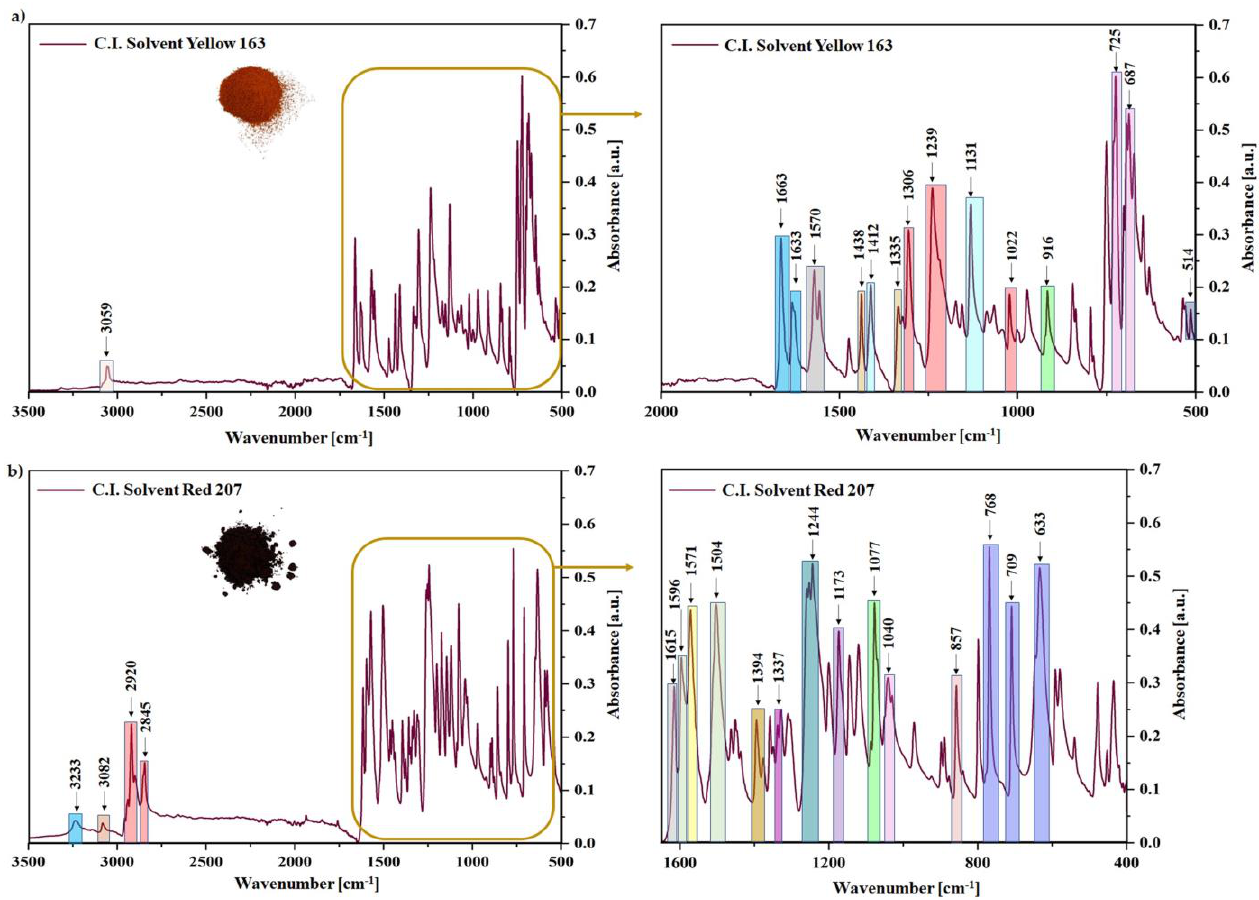
Figure 2. Fourier-transform infrared spectroscopy (FT−IR) spectra of ( a ) C.I. Solvent Yellow 163 and ( b ) C.I. Solvent Red 207 recorded in the range of 400−4000 cm −1 .